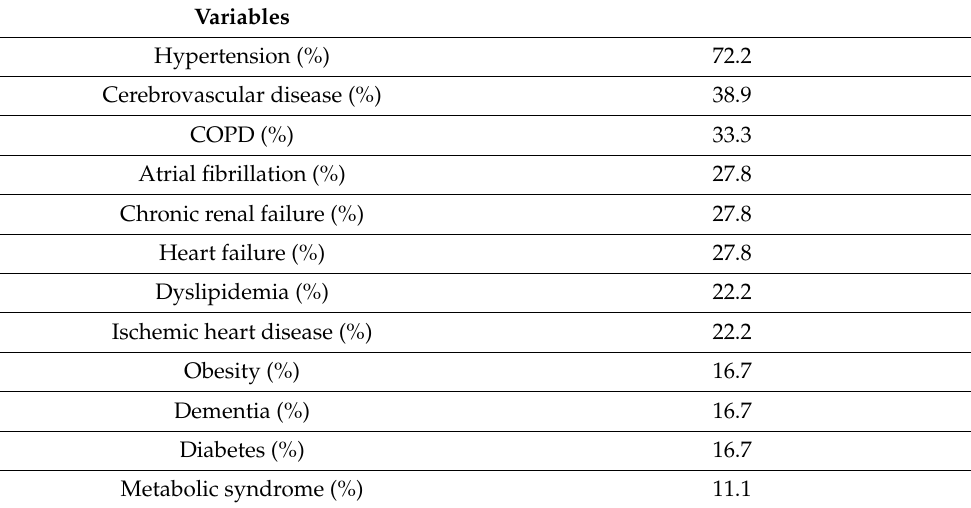
Table 2. Comorbidity distribution in hospitalized COVID-19 patients.